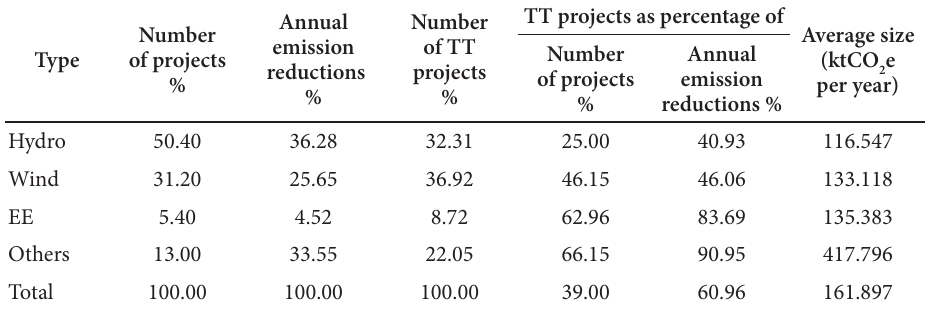
Table 2. Project type